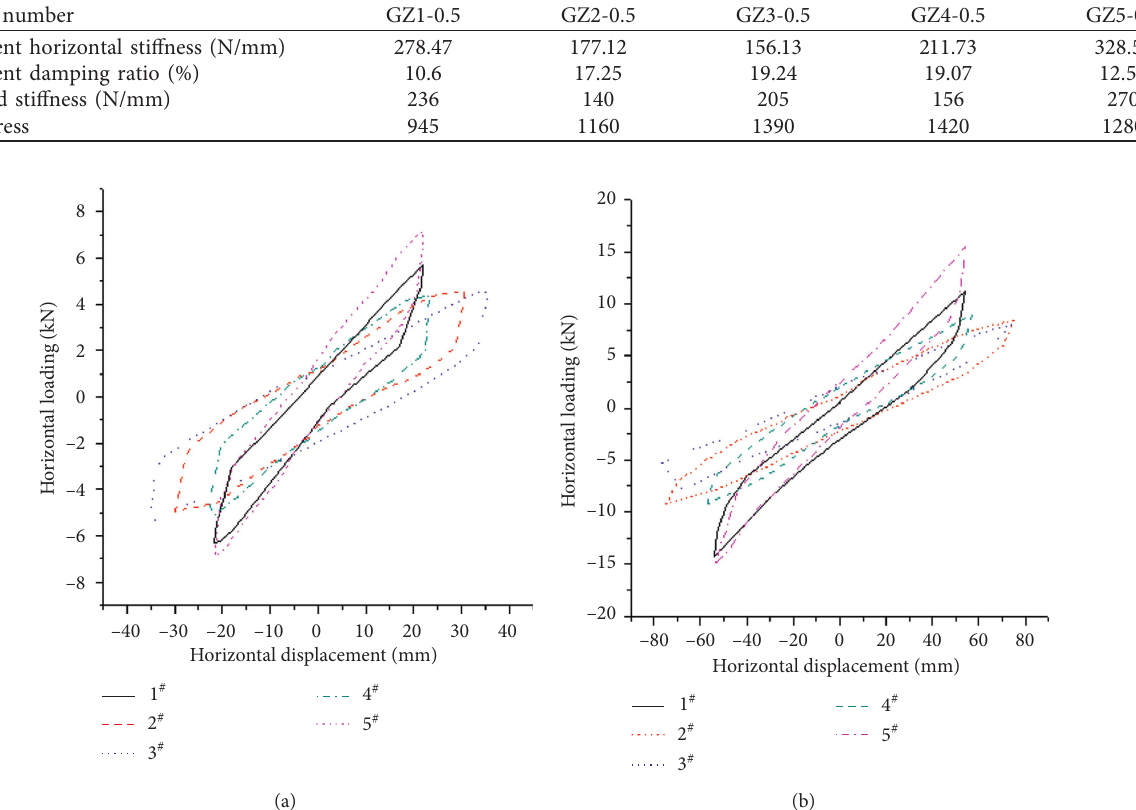
Figure 4: Supporter third hysteretic data: (a) 100% shear strain hysteretic loop; (b) 250% shear strain hysteretic loop.